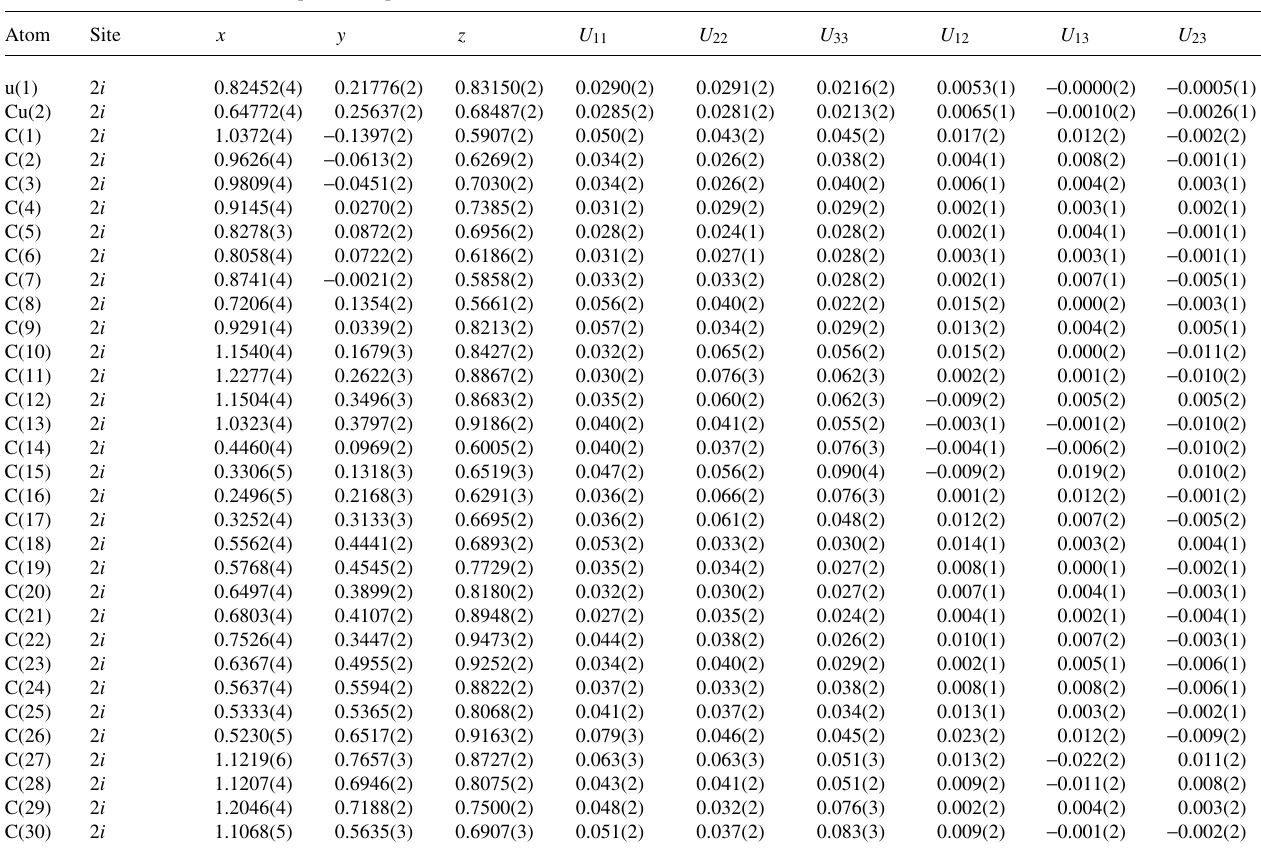
Table 3. Atomic coordinates and displacement parameters (in Å 2 ) .